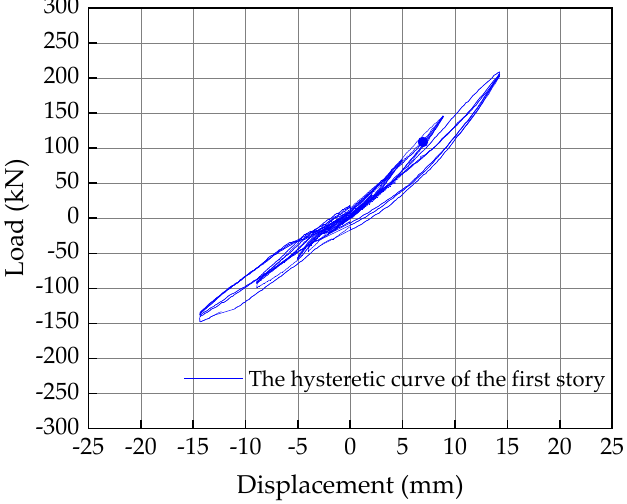
Figure 21. The hysteretic curve of the first story.